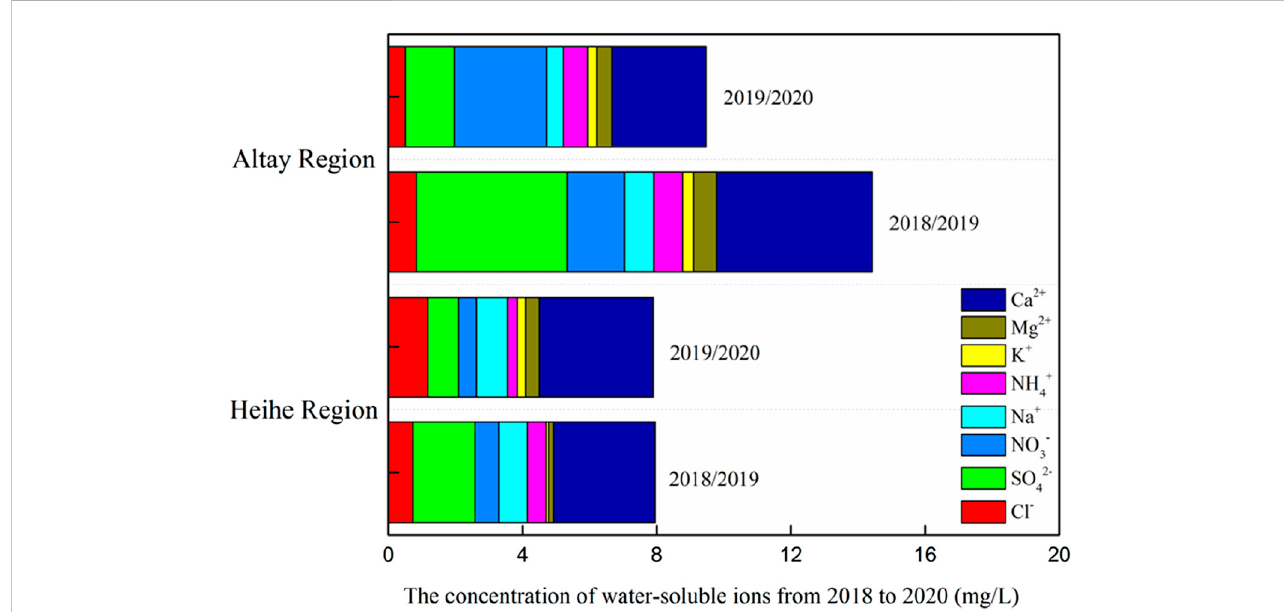
FIGURE 5 Interannual variations of several major inorganic ions in snowpack in Heihe and Altay regions during 2018 – 2020.